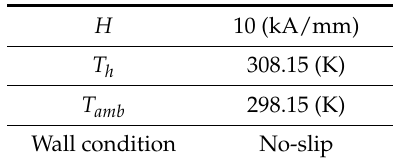
Table 3. Boundary conditions applied in this study.